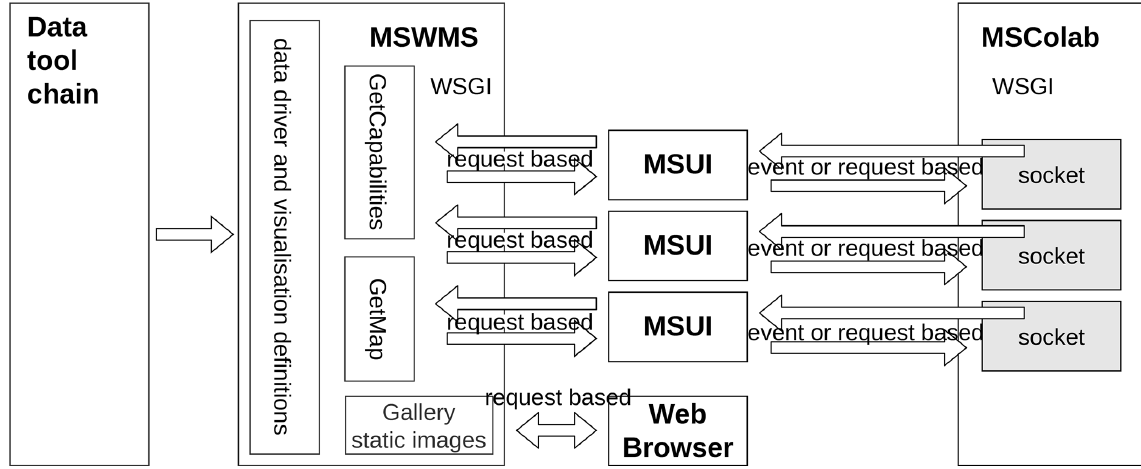
Figure 1. Data flow and architecture of the Mission Support